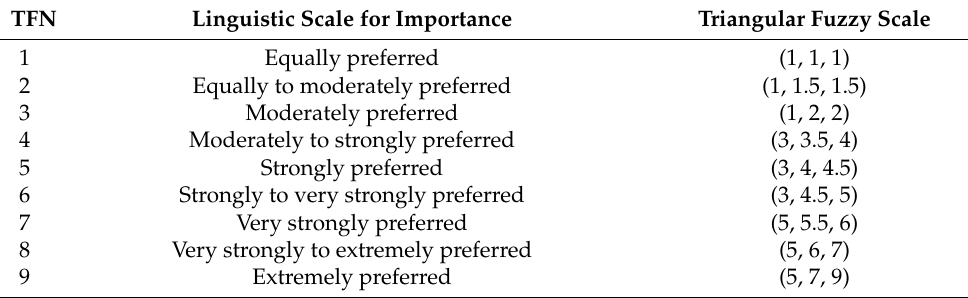
Table 4. Triangular fuzzy scale used for pairwise comparisons